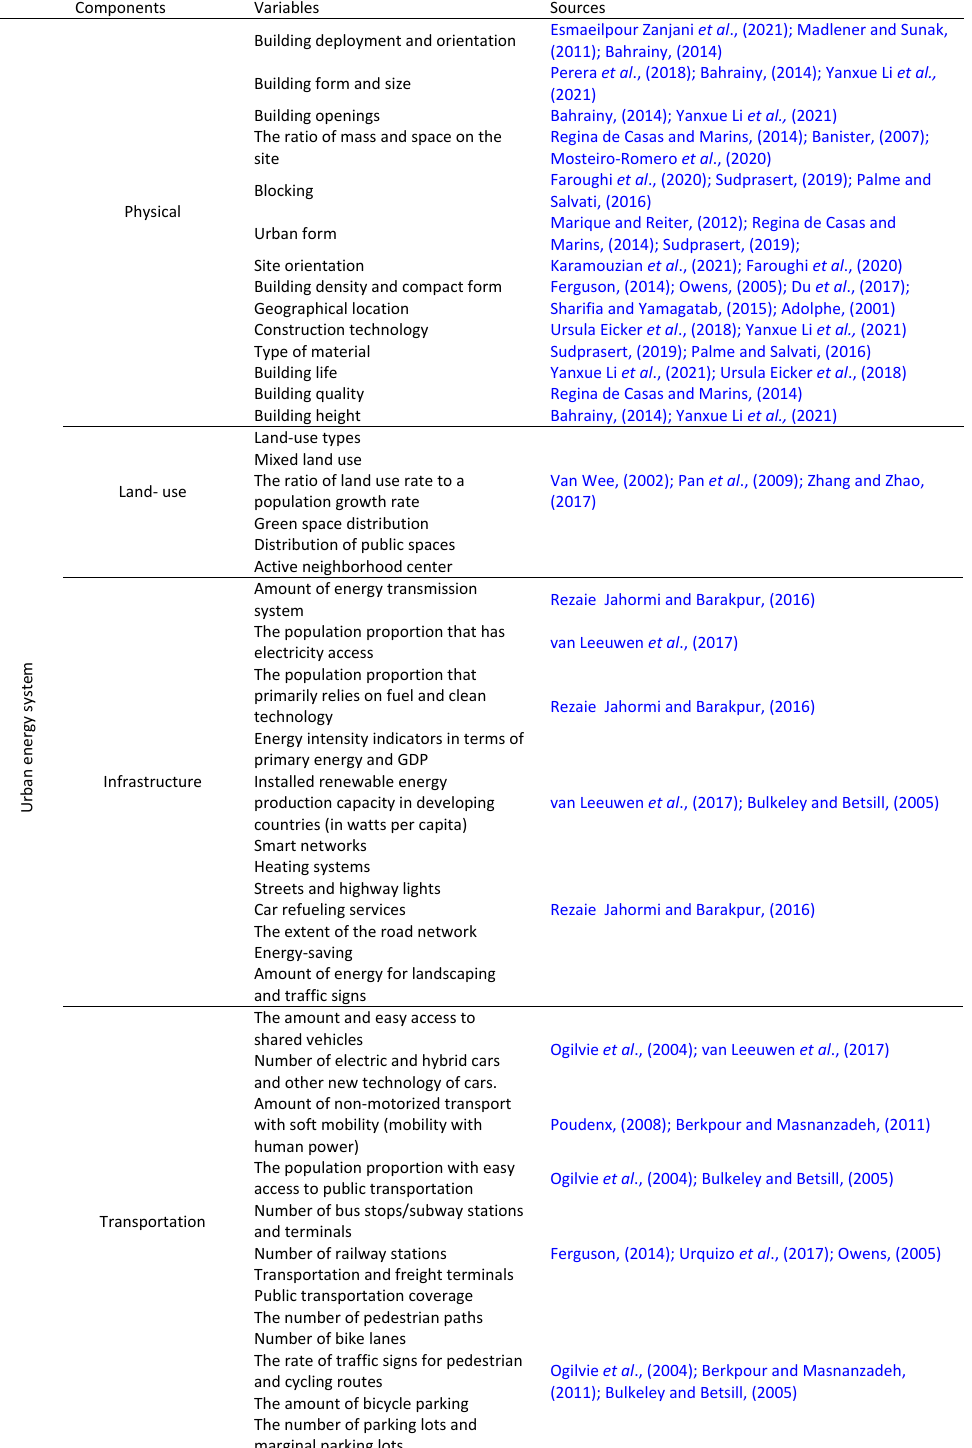
Table 1: Identifying the components, variables, and indicators of urban energy system from literature and other data collection sources.